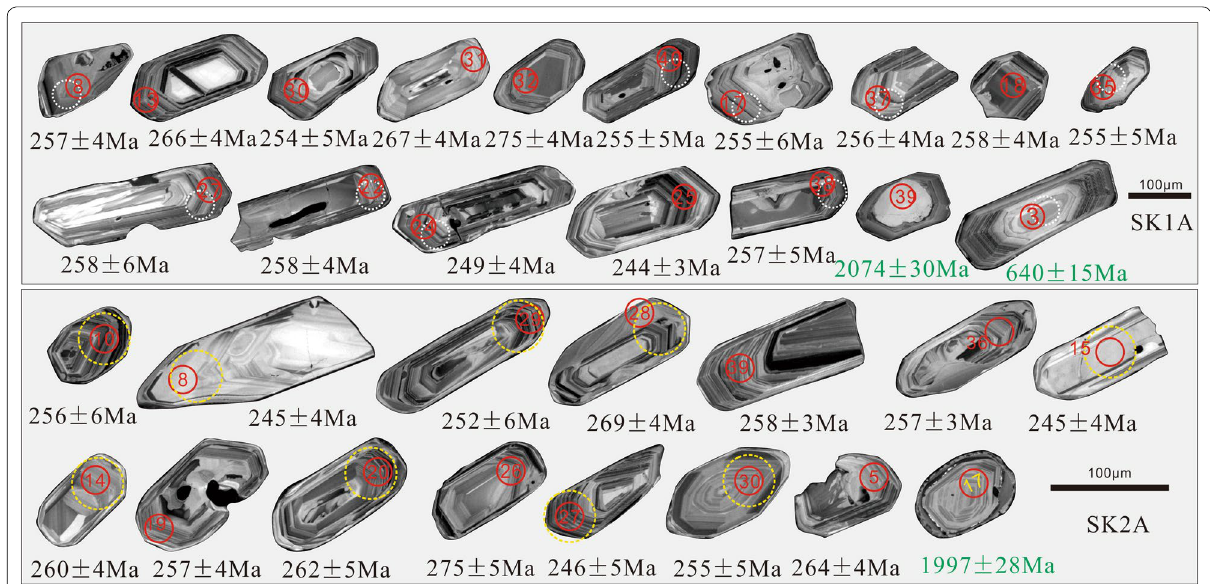
Fig. 5 CL images of zircons from the augengneiss samples (SK1, SK2) showing their internal structure and morphology. Red circles are the locations of U/Pb dating spots, the yellow ones the locations of Hf isotopic measurements. 206 Pb/ 238 U ages are given. Green numbers highlight ages of inherited